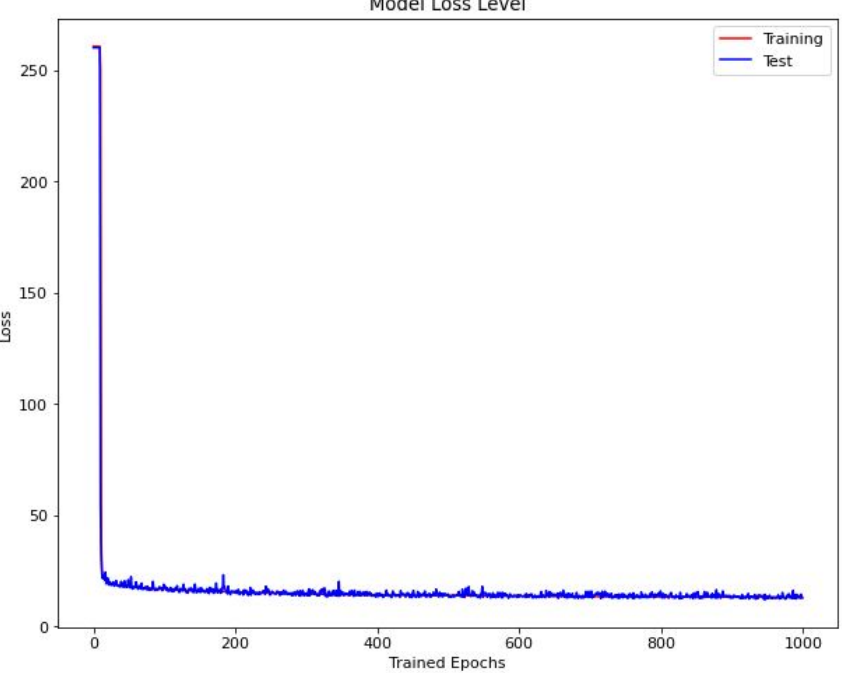
Figure 3. Model performance: predicted vs. test data.